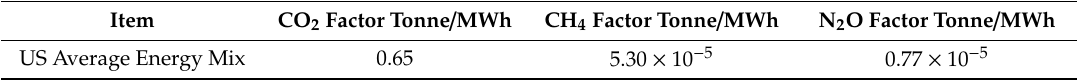
Table 3. Non-baseload emission factors.